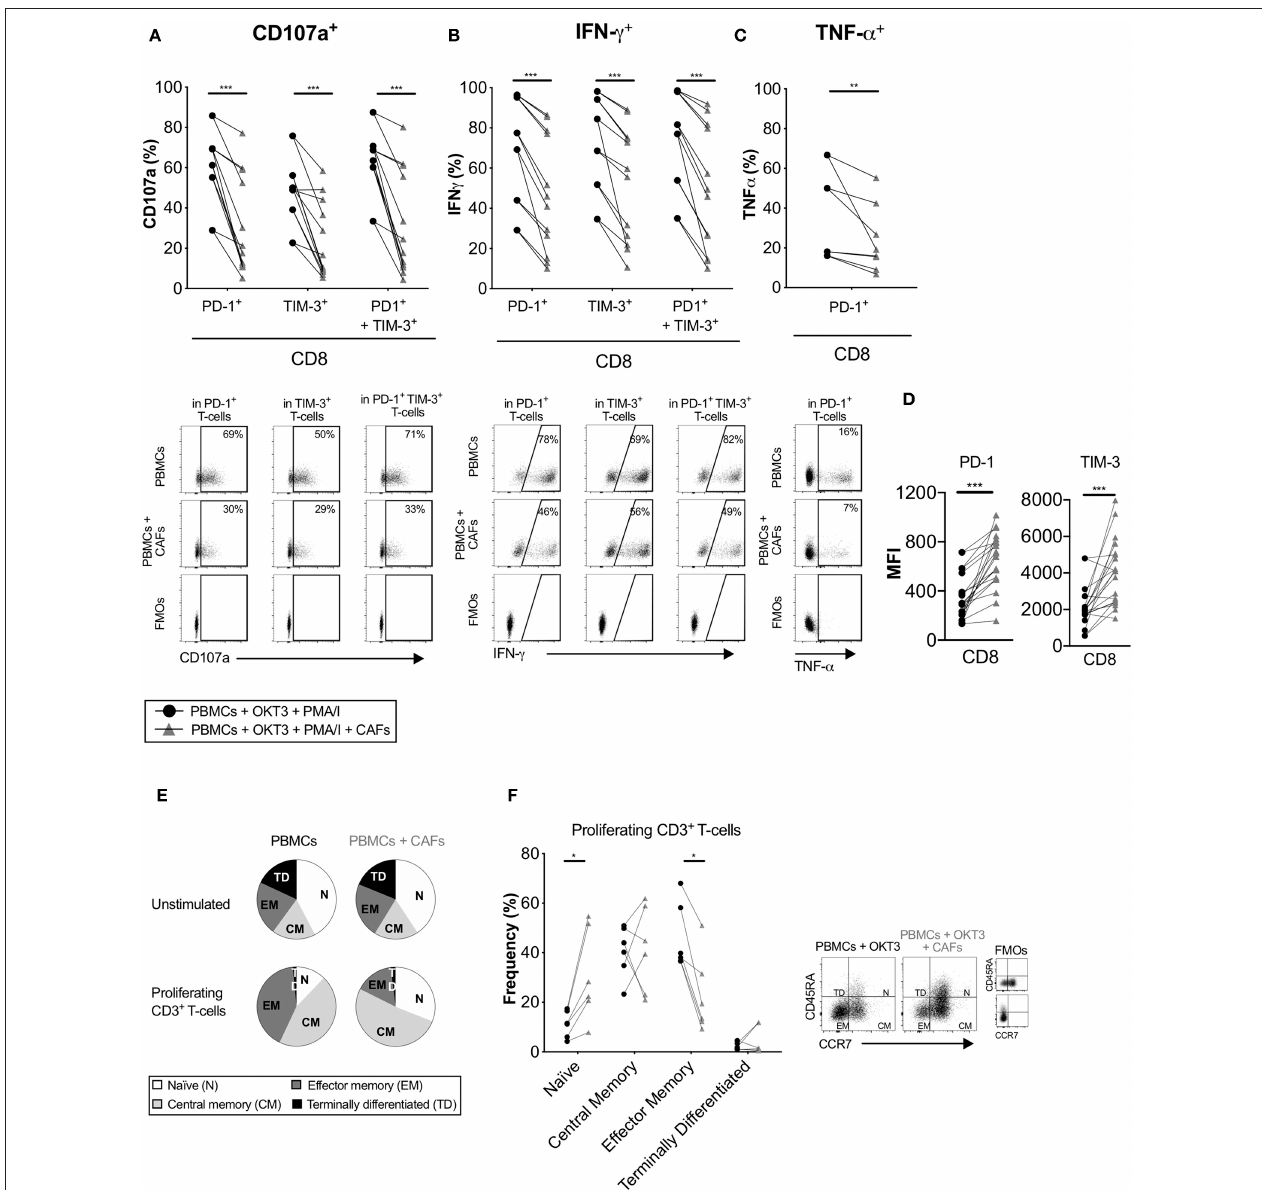
FIGURE 6 | CAFs promote non-functional T-cells. CFSE-labeled PBMCs were co-cultured in the absence (•) or presence ( N ) of CAFs and stimulated with OKT3 (25ng/ml). On day 5 PBMCs were re-stimulated with PMA/Ionomycin (I) for 6h. Expression of (A) CD107a and (B) IFN- γ in PD-1 + , TIM-3 + and PD-1 + TIM-3 + CD8 + T-cells ( n = 12). (C) Expression of TNF- α in PD-1 + CD8 + T-cells ( n = 8) (upper). Representative dot plots showing the gating strategy in (A–C) (bottom). (D) Median fluorescence intensity (MFI) of PD-1 and TIM-3 expression on CD8 + T-cells. (E) Pie charts with proportions of CD3 + T-cell memory subsets in unstimulated and proliferating T-cells after OKT3 stimulation. (F) Frequency of CD45RA + CCR7 + (naïve), CD45RA − CCR7 + (central memory), CD45RA − CCR7 − (effector memory), CD45RA + CDR7 − (terminally differentiated) expressed as percentage of proliferating CD3 + T-cells ( n = 6) in the presence or absence of CAFs (left). Flow cytometry gating strategies for naïve (N), central memory (CM), effector memory (EM) and terminally differentiated (TD) on proliferating CD3 + T-cells (right). Lines between dots indicate paired samples. Wilcoxon matched-pairs signed rank test was used to detect statistically significant differences * P < 0.05, ** P < 0.01, *** P <